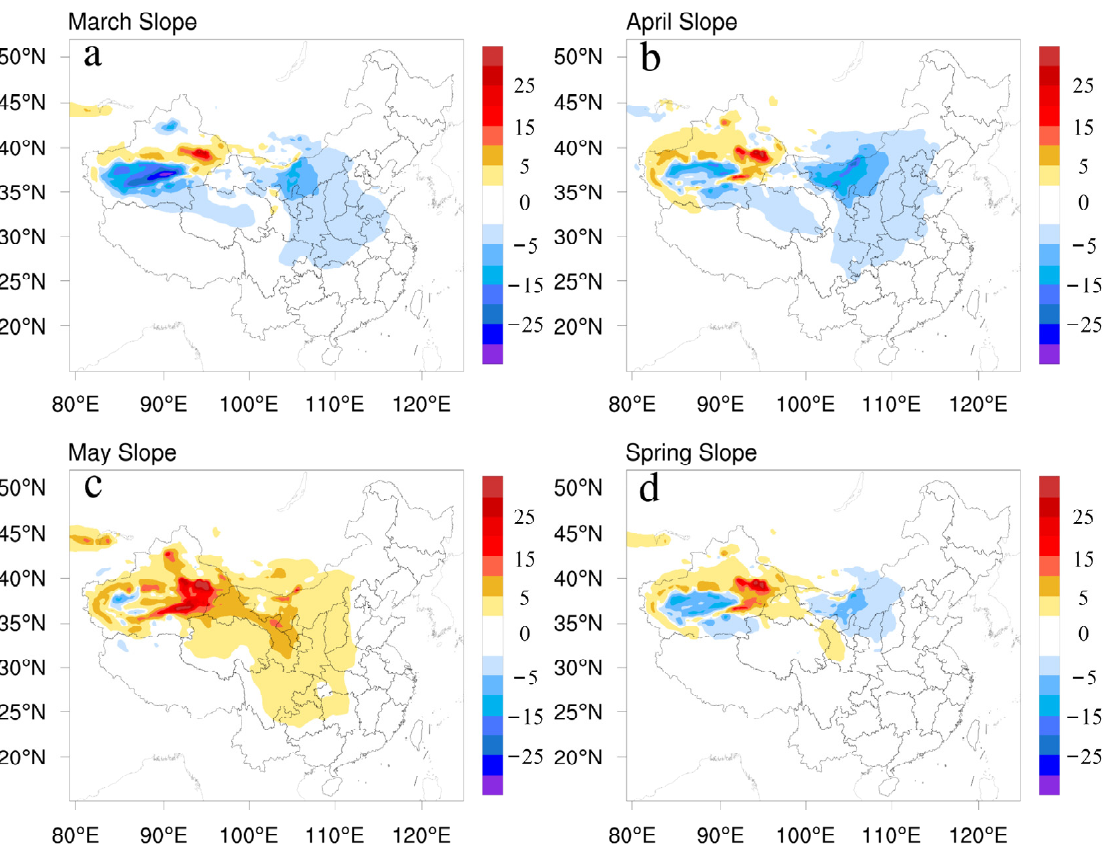
Figure 6. Spatial distributions of linear trends regarding dust concentrations ( µ g kg − 1 -dry air yr − 1 ) in March ( a ), April ( b ), May ( c ), and spring ( d ) during 2000–2020.